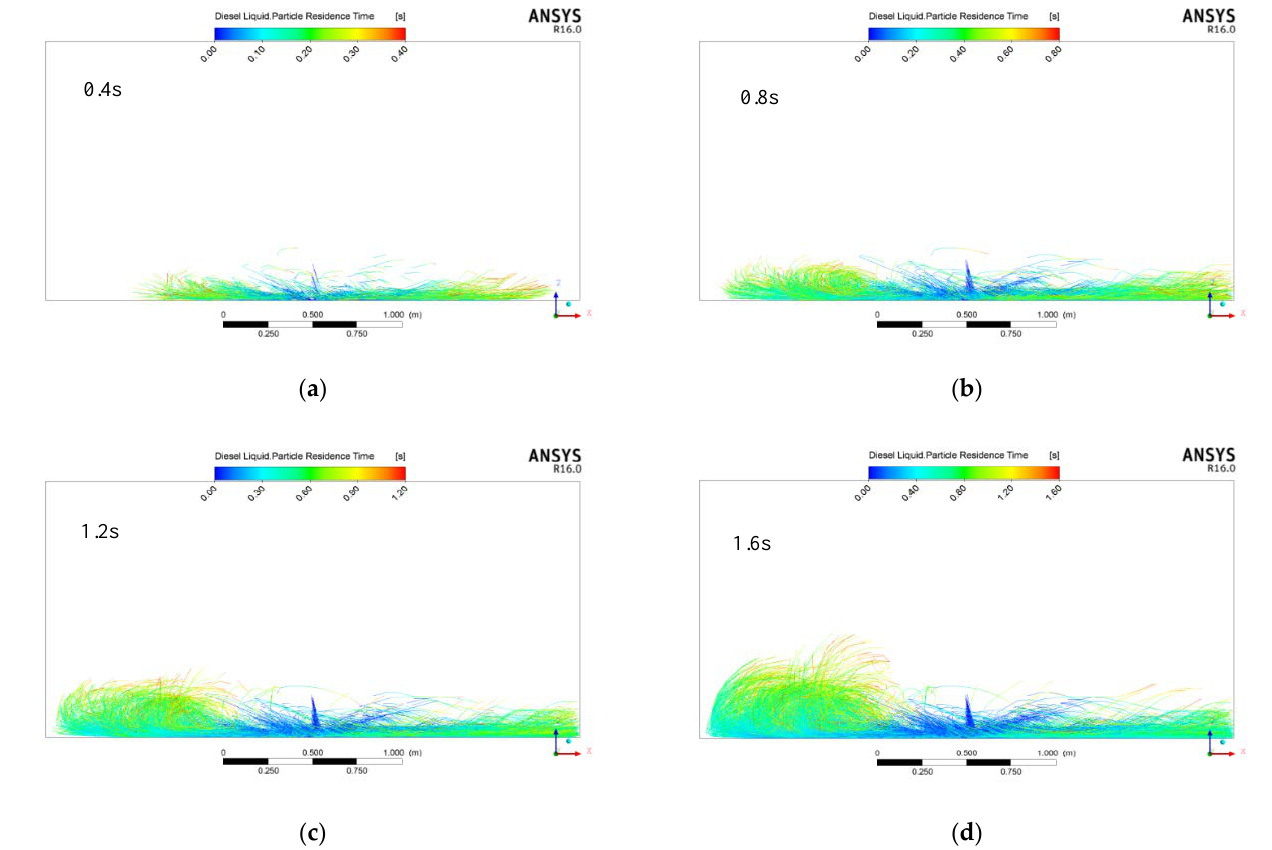
Figure 20. Motion trajectory at different times: ( a ) 0.4 s; ( b ) 0.8 s; ( c ) 1.2 s; ( d ) 1.6 s.